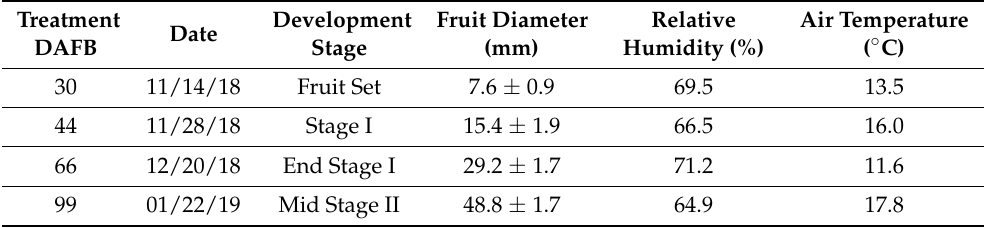
Table 1. Description of the application times to the 45 Ca tracer. Days after full bloom (DAFB), dates, development stages, fruit diameter, and environmental